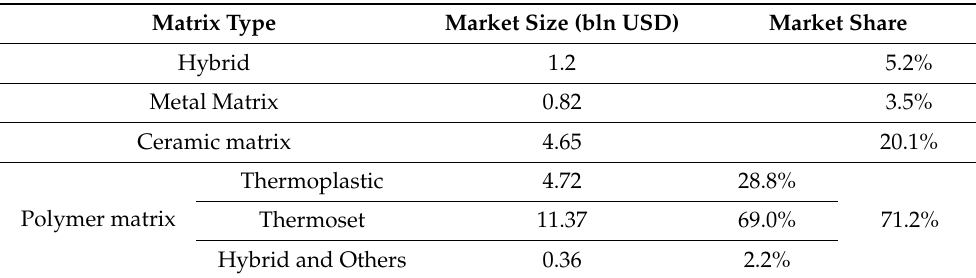
Table 1. Distribution of the global CFRP market by matrix material